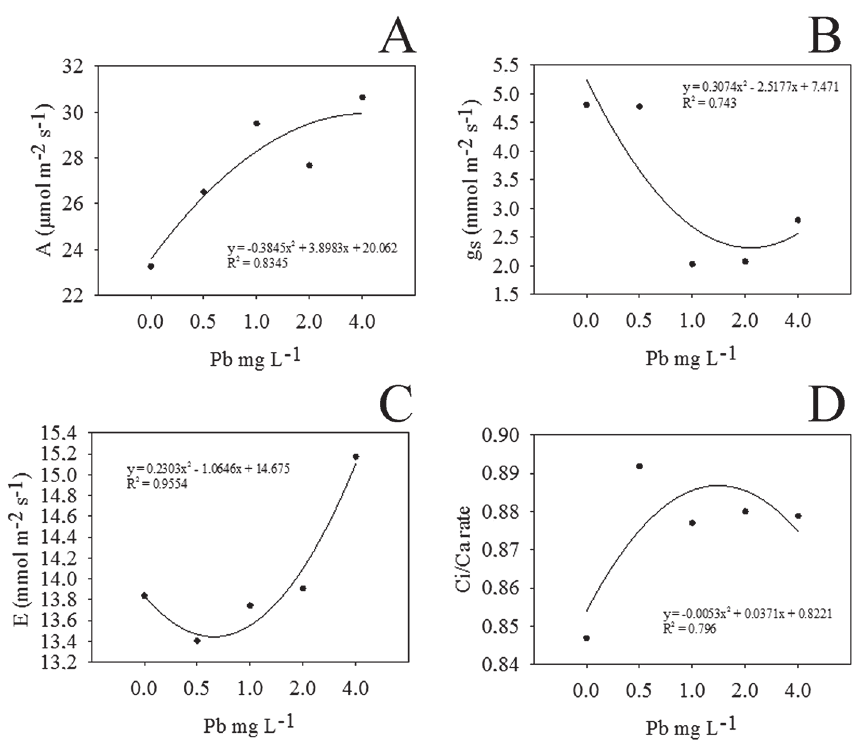
Figure 1 - Gas exchanges characteristics of Eichhornia crassipes grown in nutrient solutions under different lead concentrations. A = photosynthesis, B = stomatal conductance, C = transpiratory rate, D = Ci/Ca rate. bars= standard error.